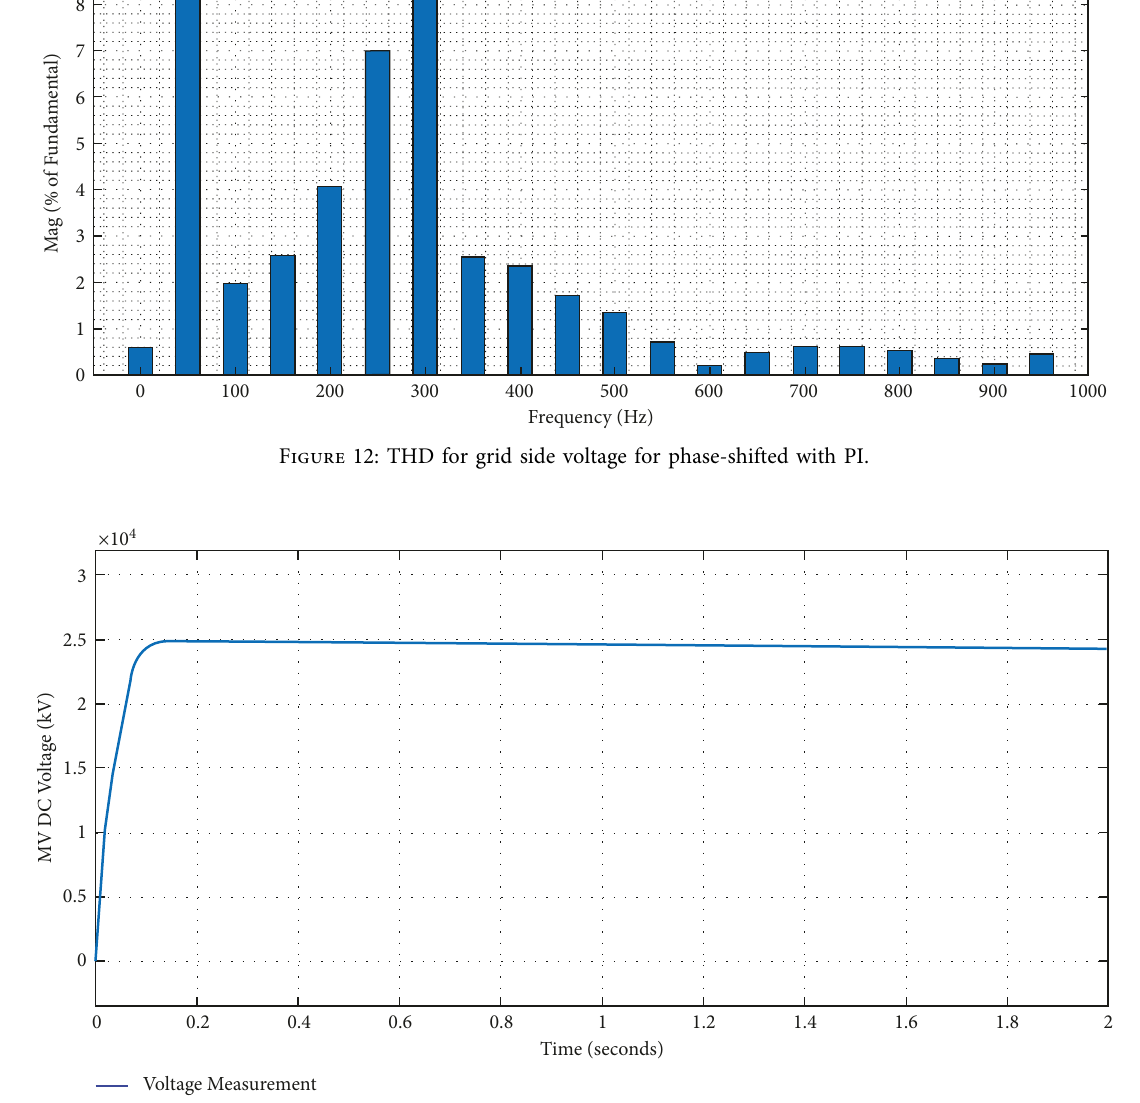
Figure 13: MV DC link voltage wave for PI with phase shift PWM.